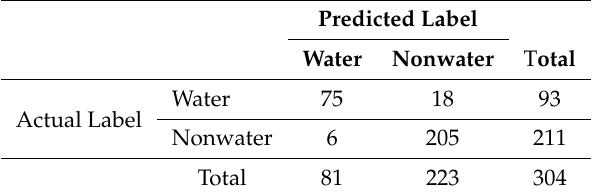
Table 3. Confusion Matrix After Test Set